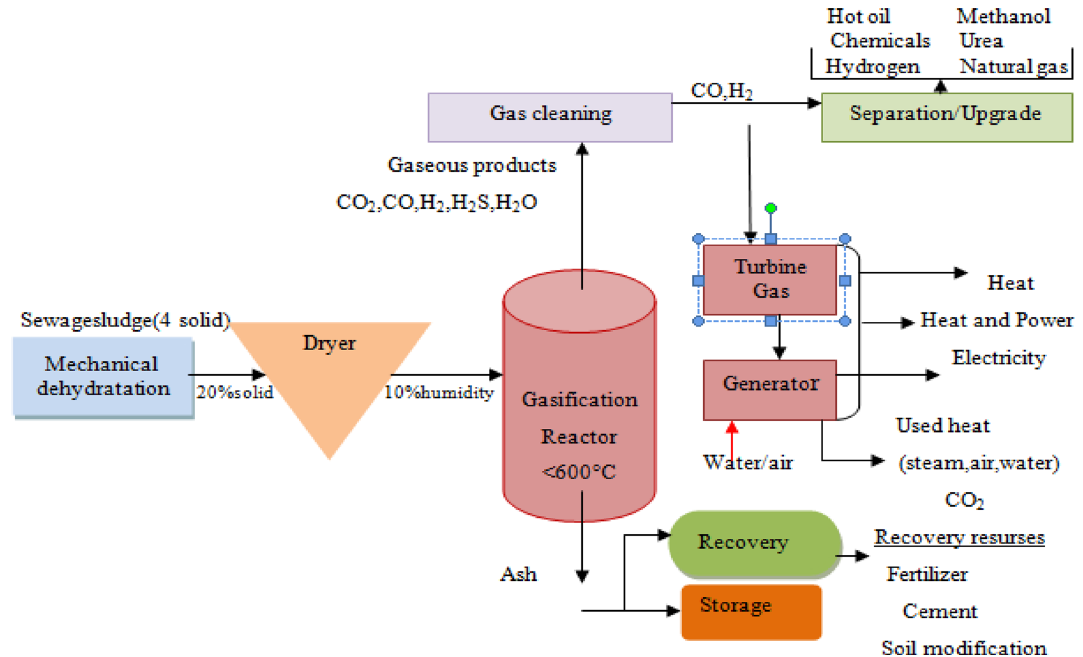
Fig. 6 Gasification processof sewage sludge